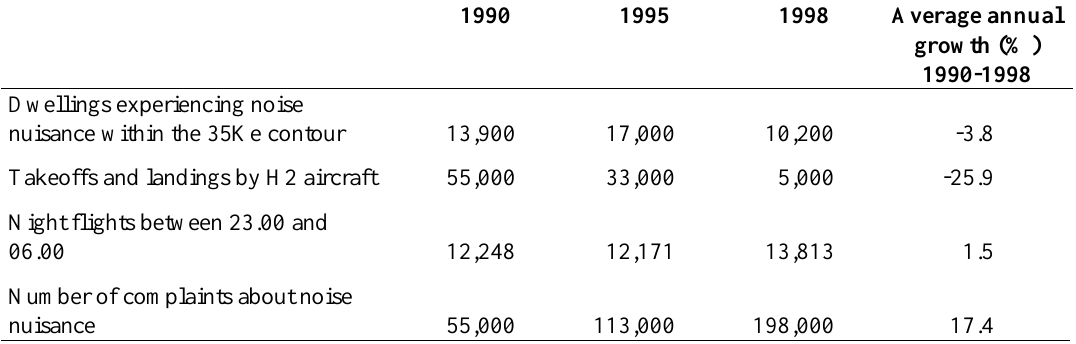
Table 5. Development of noise indicators at Amsterdam Airport Schiphol,